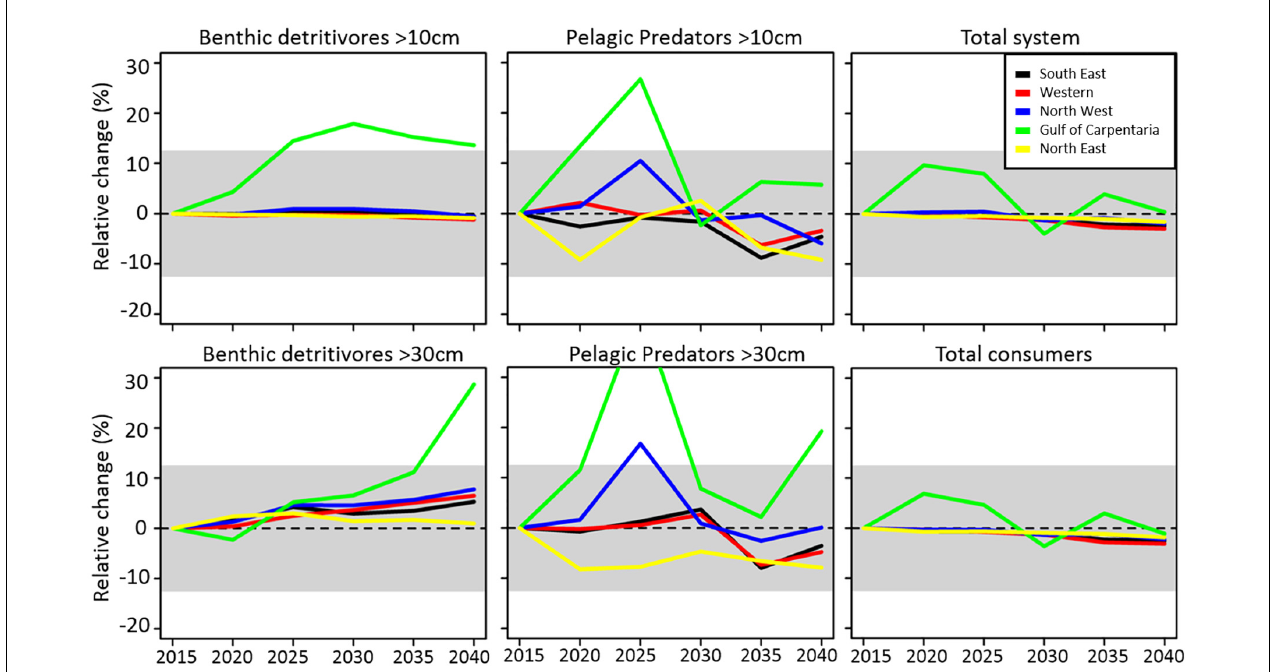
FIGURE 5 | Global benthic-pelagic size spectrum model projections of relative changes in biomass density of different model groups at 5-year intervals for each Australian region under the RCP8.5 scenario without fishing. These model outputs therefore represent relative changes in the unexploited baseline of biomass due to climate forcing